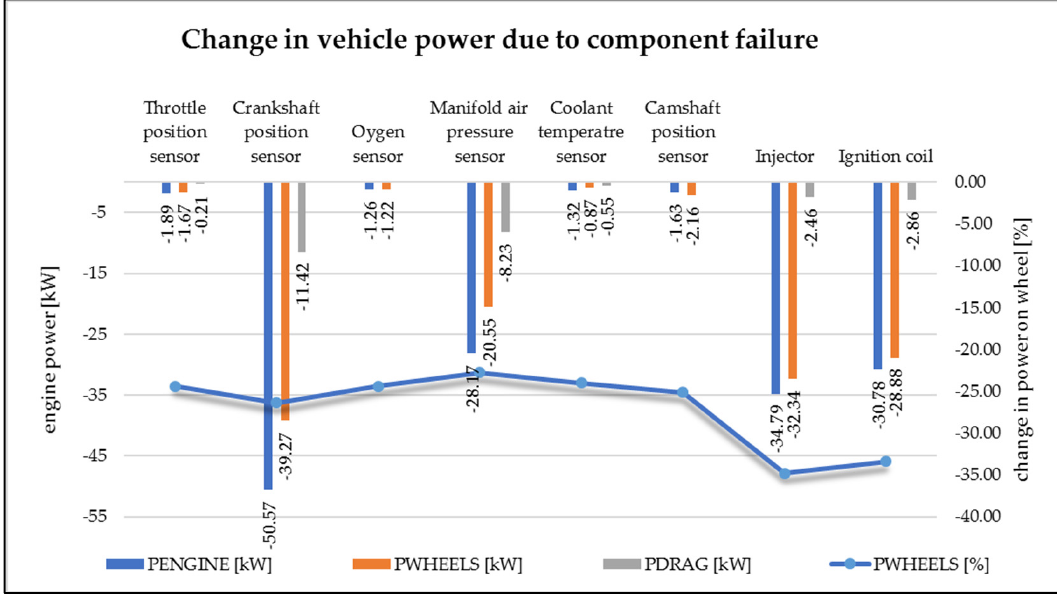
Figure 4. Change in engine power due to electronic component failure (author).